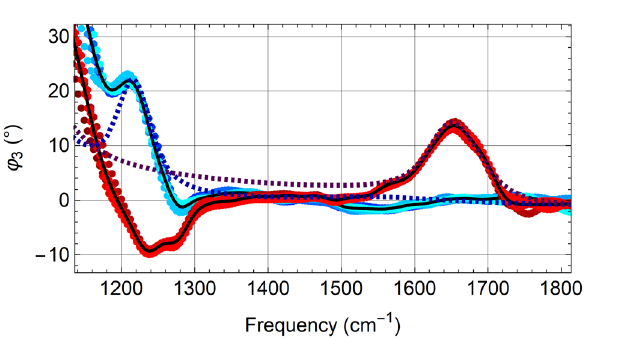
Figure 2. s-SNOM-observed membrane wetting, ( A ) infrared amplitude s 2 and ( B ) topography z nanoimages of a free-standing 20-nm thick SiN membrane on its Si frame (scale bars 2 µm), as-received exhibits a partial wetting in the lower left corner of the 20 × 20 µm 2 hole (Norcada NX5002Y), ( C ) after UV hydrophilisation and complete wetting, line profiles are extracted from images (not shown) of infrared amplitude s 2 (red), topography z (black), and mechanical phase φ mech (blue) across an edge (at x = 0) of the frame into the membrane.